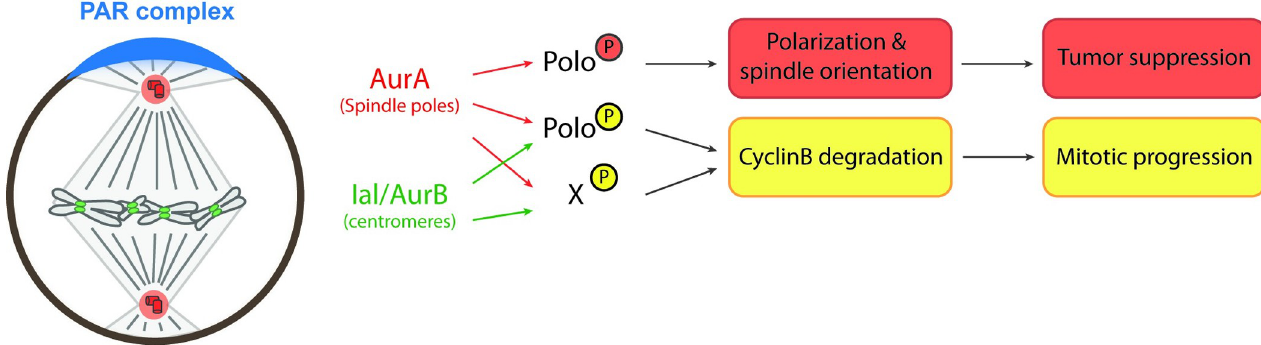
Fig 6. Model showing Aurora(s)-dependent activation of Polo kinase for mitotic progression and tumor suppression in NSCs. In fly NSCs, centrosomal/ spindle pole-associated Aurora A kinase phosphorylates the Polo activating T182 of to generate active Polo kinase. This event is essential to regulate PAR complex polarized localization/activation and avoid tumor suppression. This activation is possible without centrosomes. To promote timely Cyclin B degradation and mitotic progression, Polo activation requires T182 phosphorylation by both spindle pole-Aurora A and centromeric Ial/Aurora B. This event occurs in parallel of the Spindle assembly checkpoint. Downstream Aurora A and Ial/Aurora B uncharacterized targets participate to this